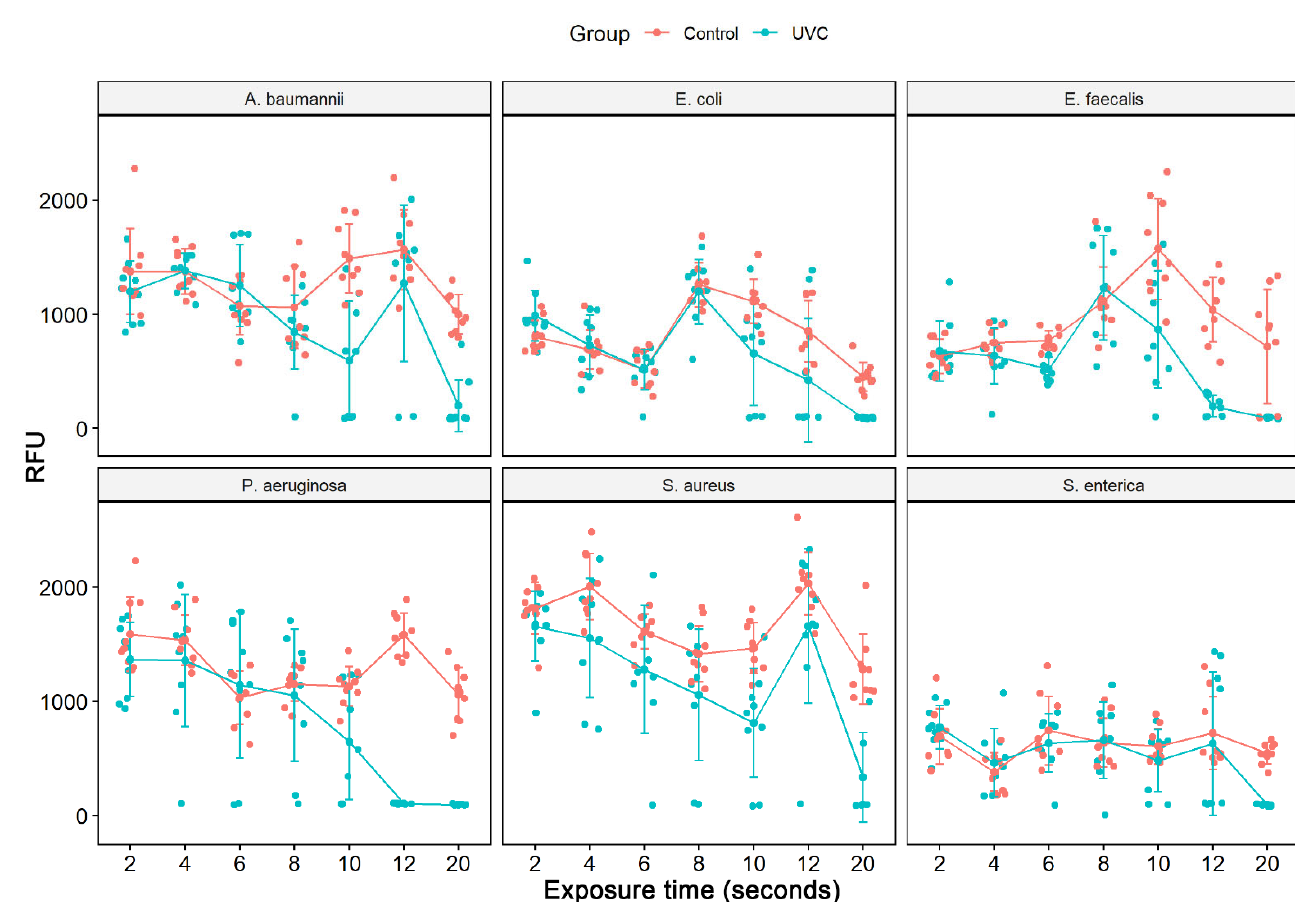
Figure 1. Analysis of cell viability by the addition of resazurin after treatment with UV ‐ C system and control group (no treatment) in different bacterial strains ATCCs ( S. aureus (ATCC 6538), P. aeruginosa (ATCC 15442), S. enterica (ATCC 10708), E. coli (ATCC 25922), A. baumannii (ATCC 19606) and E. faecalis (ATCC 29212)). The measured fluorescence intensity (Relative Fluorescence Units, RFU) after the conversion of resazurin to resofurin by viable bacteria was performed either in the control group (no treatment) as in the bacterial suspensions (1:100 dilution) after exposure to the UV ‐ C (2, 4, 6, 8, 10, 12 and 20 s). Results represent values from 3 experiments in triplicate. [times (sec) of UV ‐ C exposure].